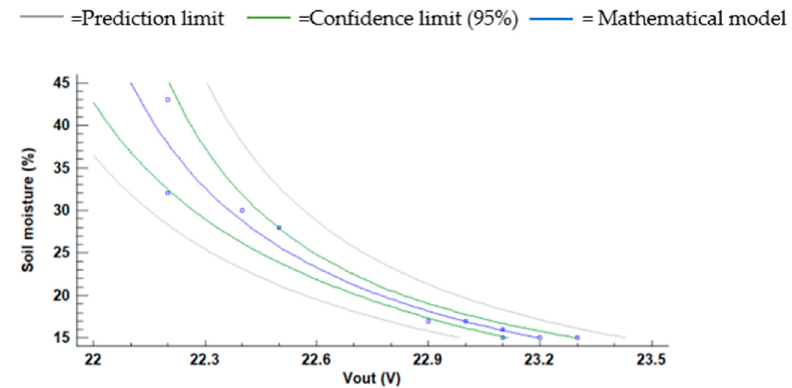
Figure 19. Vout of P5 using S2 and its mathematical model .